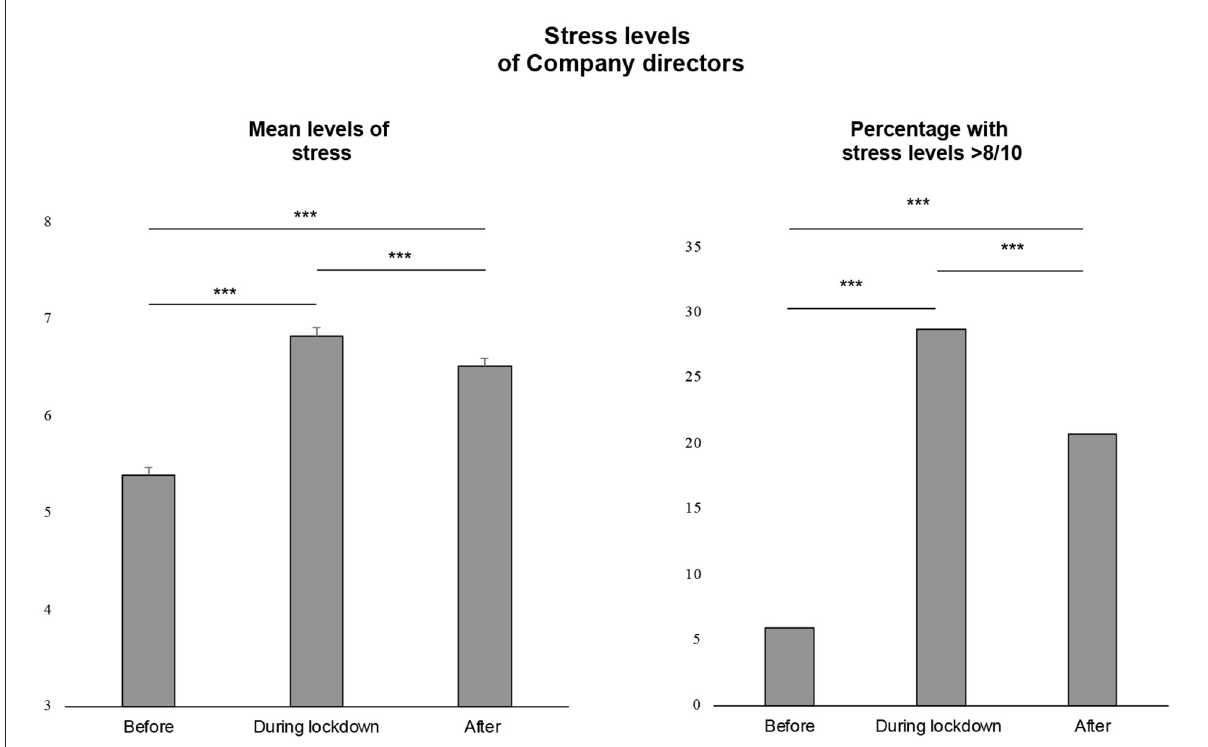
FIGURE3 Stress levels of company directors (mean levels ± standard error of the mean and percentage with stress levels > 8/10). ***: significant changes between periods ( p <